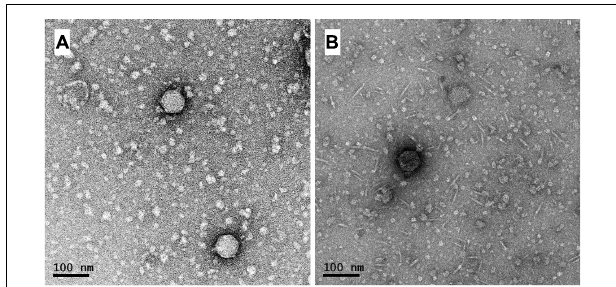
FIGURE 1 | Morphology of phage vTRX32-1 and RHEph01 shown by transmission electron microscopy. vTRX32-1 (A) follows the morphology of previously described RHEph01 (B)